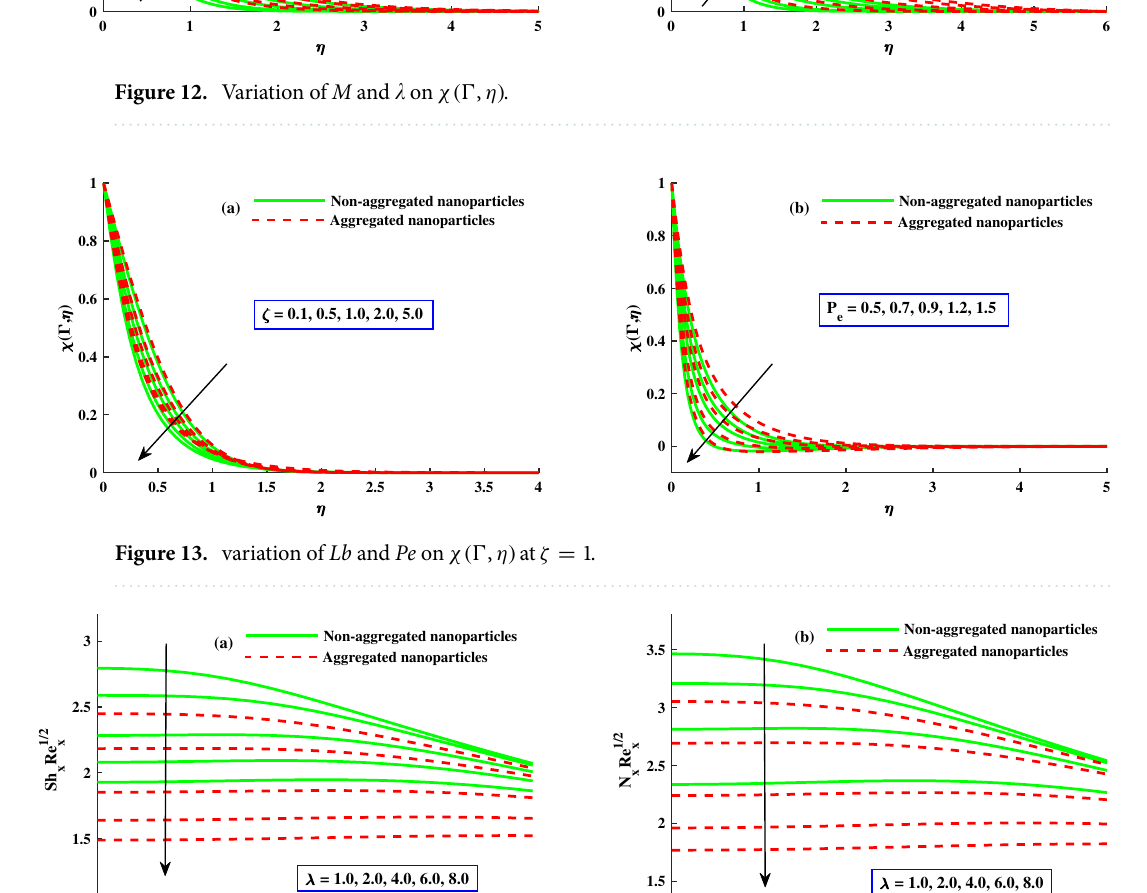
Figure 12. Variation of M and (cid:31) on χ(Ŵ , η) .